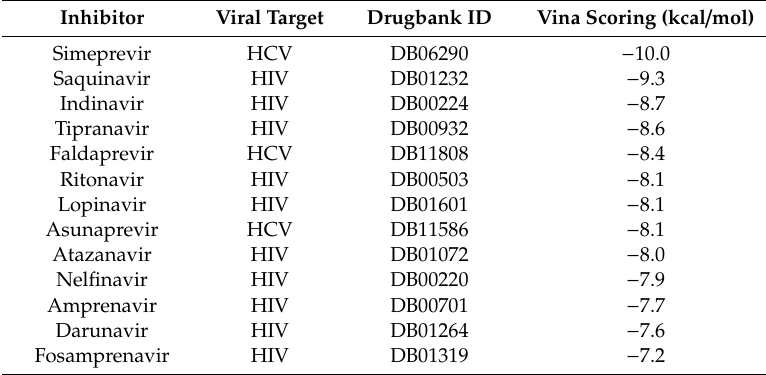
Table 1. Results from molecular docking of thirteen di ff erent antiviral protease inhibitors. The second column indicates the original viral target of each compound (hepatitis C virus (HCV), human immunodeficiency virus (HIV)).